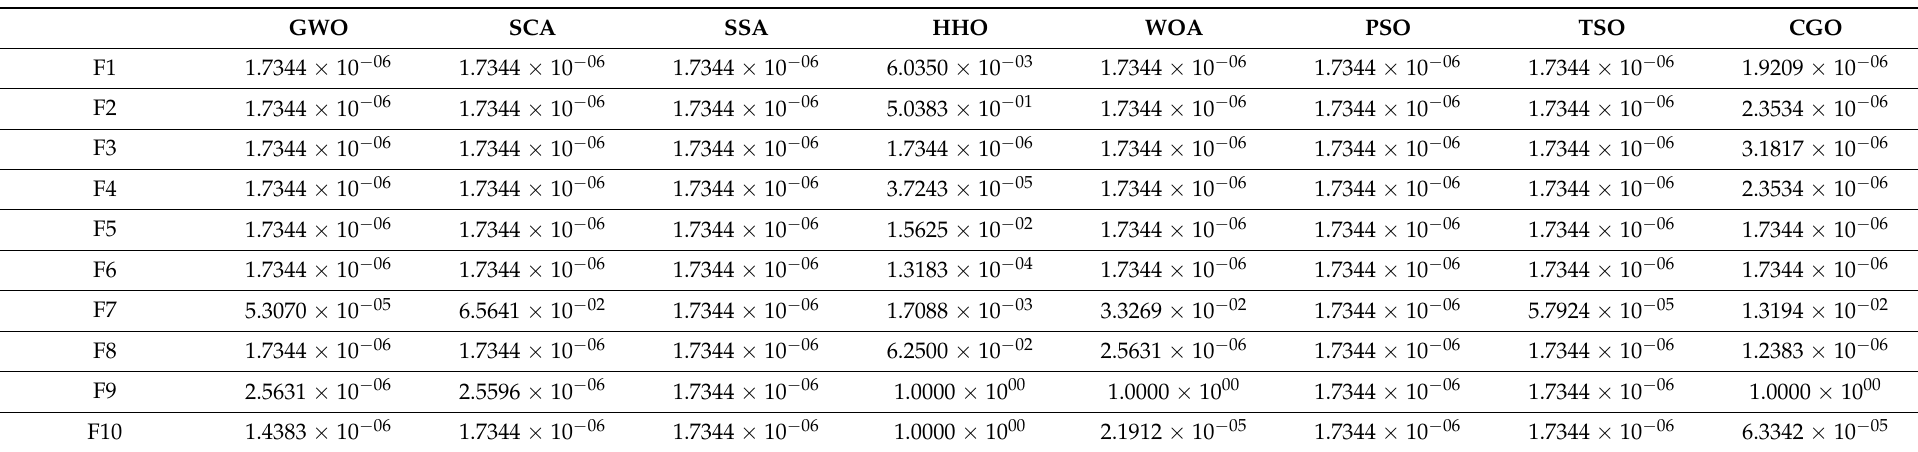
Table 7. The p -values of the null hypothesis t -test of CSA versus other